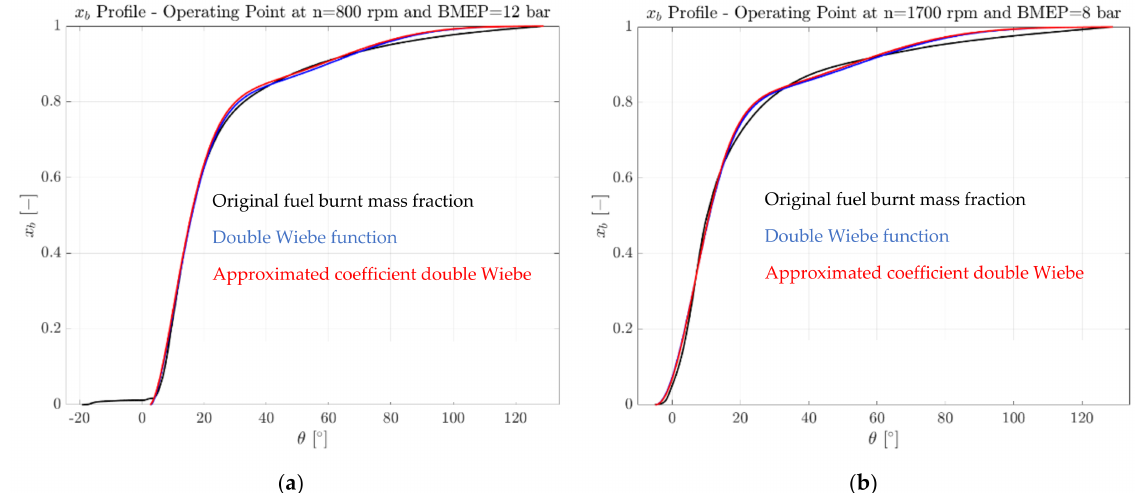
Figure 9. ( a ) Fuel burnt mass fraction profile for the operating point at n = 800 rpm, BMEP = 12 bar. This is characterized by a double injection (a pilot and a main one), however the assumption of neglecting the pilot injection (for the fitting of the double-Wiebe function) is accurate; ( b ) Fuel burnt mass fraction profile for the operating point at n = 1700 rpm, BMEP = 8 bar (with single injection, in this